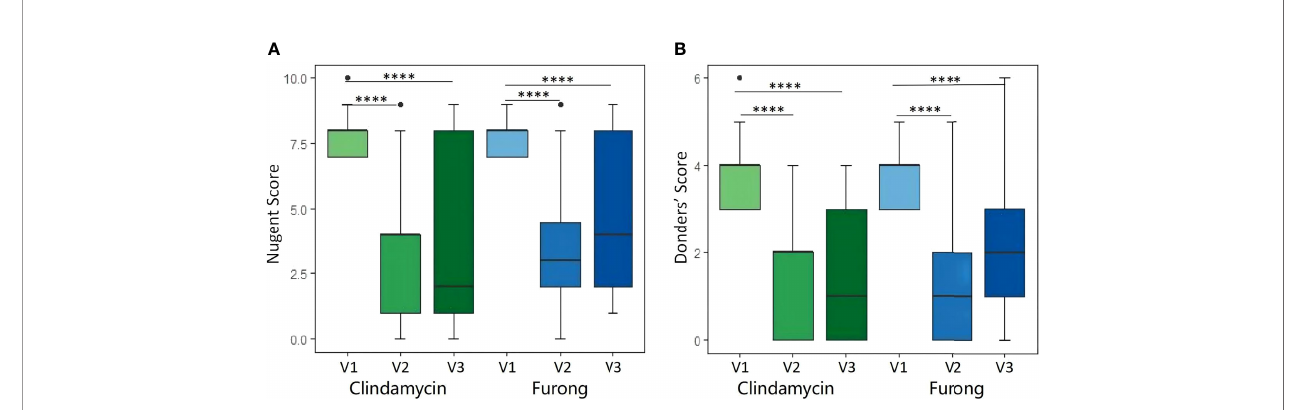
FIGURE 1 | Nugent score (A) and Donders score (B) before and after Clindamycin and Furong treatments. (****P value